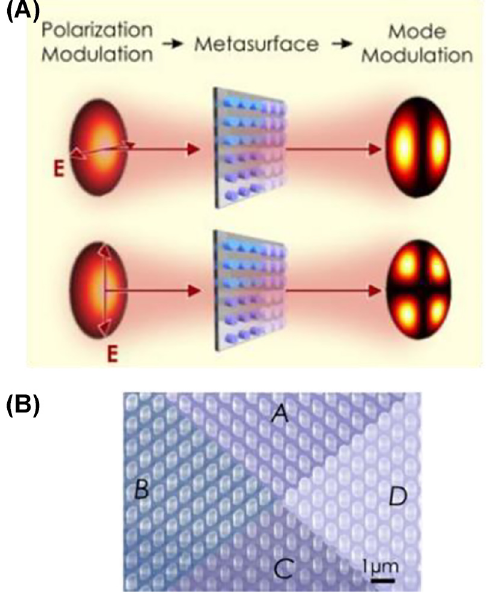
Figure 7: Metasurface generated OAM for the mode multiplexing in fiber and free-space optical communications. (A) Polarization modulation in metasurface. (B) SEM image of the metasurface [93,